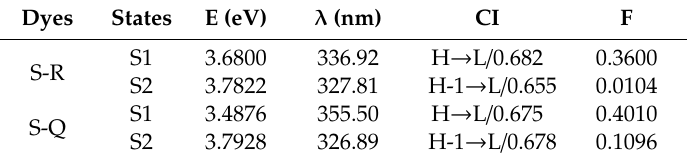
Figure 5. Absorption spectrum of S-Q and S-R in experiment and theoretical simulation. Table 3. Calculated transition energies and oscillator strengths of S-Q and S-R.